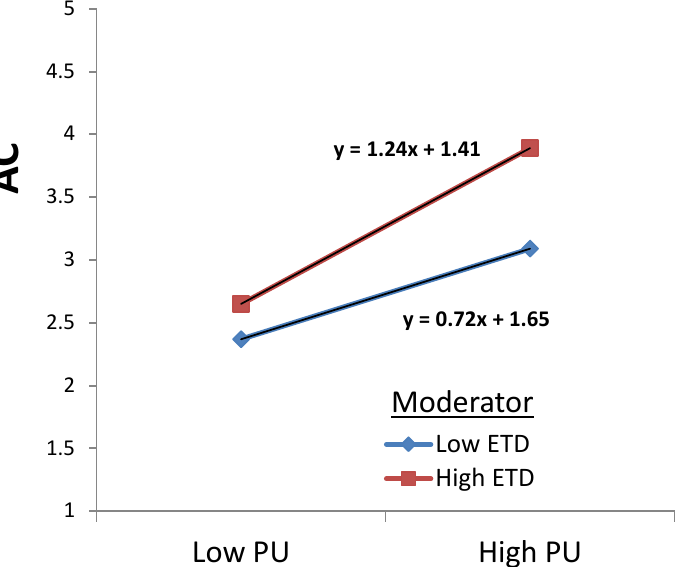
Figure 5. The impact of empathy for the disabled (ETD) on the relationship between the perceived usefulness of IoT data use for universal design purposes (PU) and the acceptance of the use of this data (AC). Empathy toward the disabled (ETD) strengthens the positive relationship between perceived usefulness (PU) and acceptance of IoT sensors (AC) by 42%.